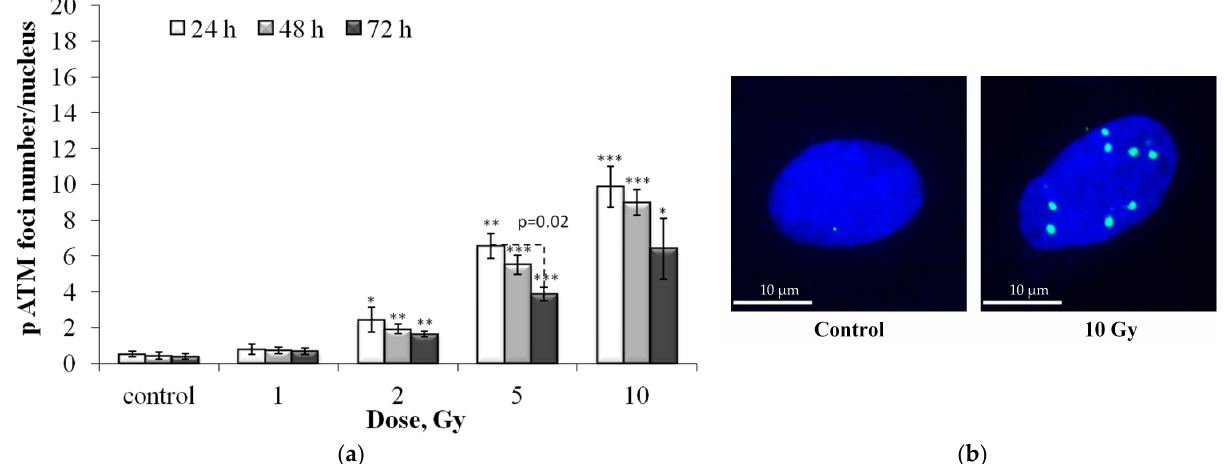
Figure 2. ( a ) Dose-dependent changes in the number of residual pATM foci in human fibroblasts 24 h, 48 h and 72 h after irradiation. Data are means ± SE of three independent experiments. * p < 0.05, ** p < 0.01 and *** p < 0.001—compared with the corresponding time of control; ( b ) Representative microphotographs of immunocytochemically stained control and 10 Gy irradiated cells (24 h) showing nucleus (blue) and foci (green).